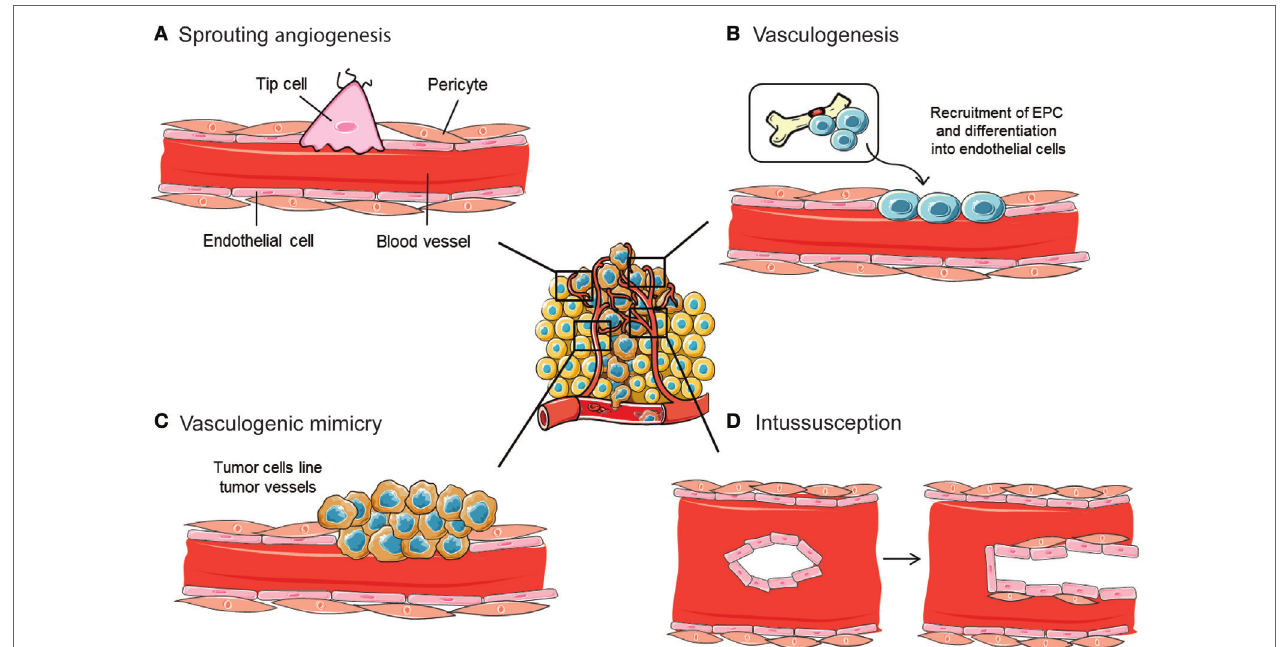
FigURe 2 | Mechanisms implicated in blood vessel formation. In the tumor ecosystem, blood vessels grow by sprouting angiogenesis (A) . In addition, less frequent neovascularization mechanisms include recruitment of bone marrow-derived endothelial progenitor cells (EPCs) (B) , intussusceptive microvascular growth (C) , and vasculogenic mimicry (D) . Figure was created using Servier Medical Art according to a Creative Commons Attribution 3.0 Unported License guidelines 3.0 (https://creativecommons.org/licenses/by/3.0/). Simplification and color changes were made to the original